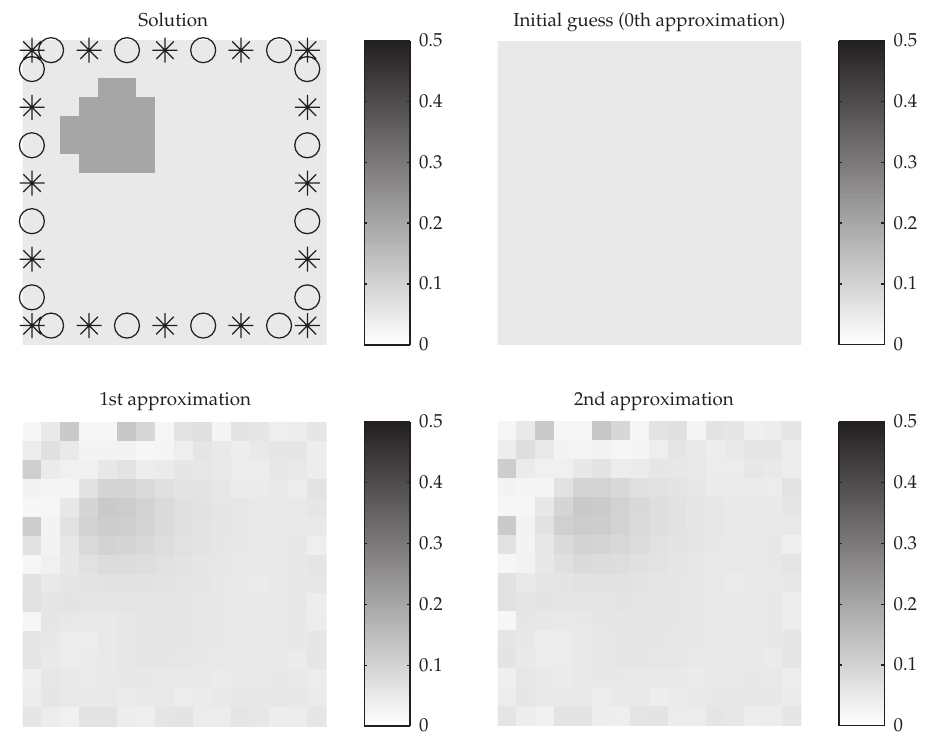
Figure 3: Jindex (cid:10) Nx ∗ Ny ∗ 0 . 3, Jalpha (cid:10) 1 . 8227 e − 7, 10% noise, sources (cid:6) ∗ (cid:8) and detectors (cid:6) o (cid:8)